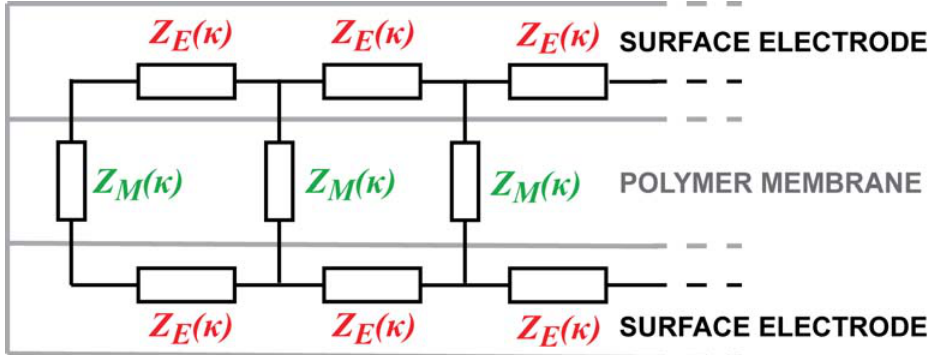
Figure 3. General equivalent circuit of ion-conducting